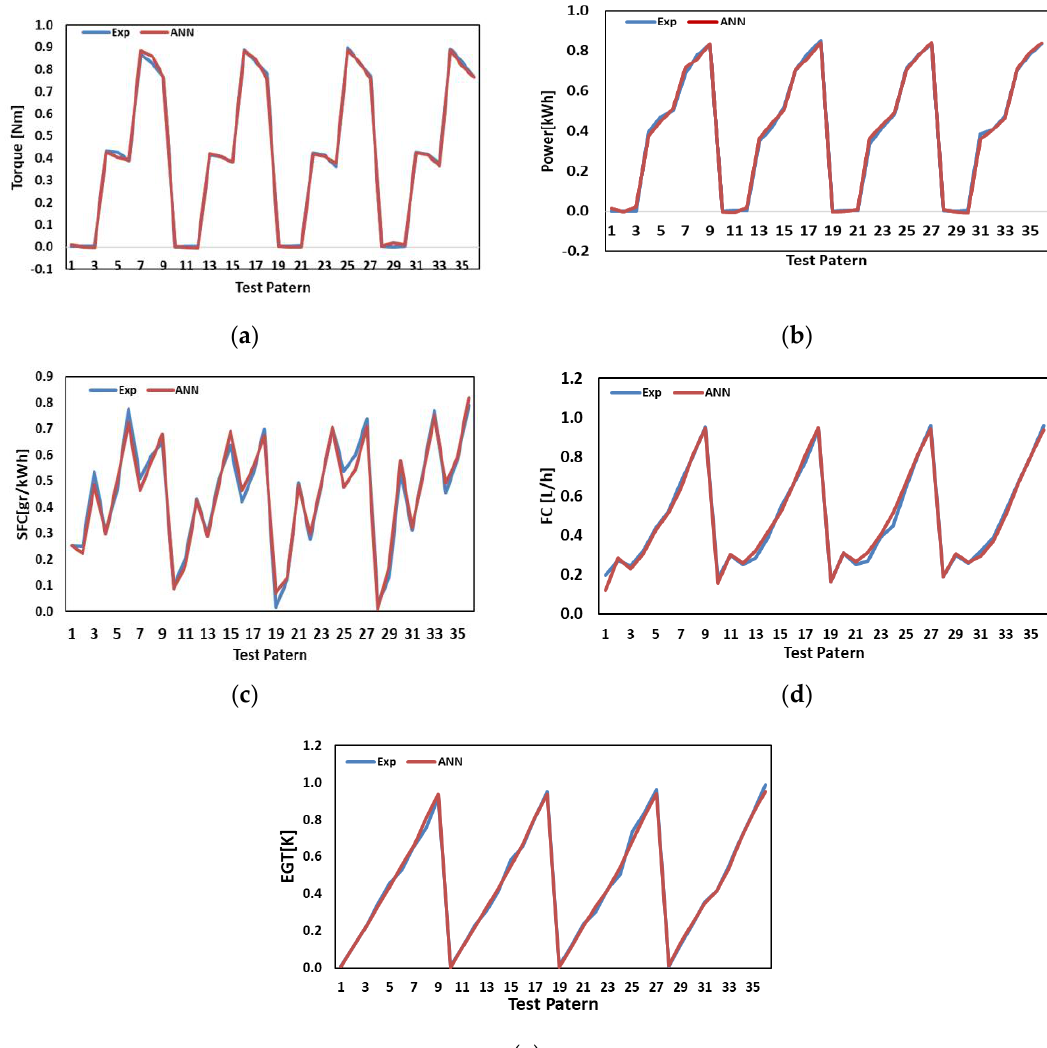
Figure 11. Comparison of experimental and prediction torque ( a ), power ( b ), SFC ( c ), FC ( d ) and EGT ( e ) data by ANN.